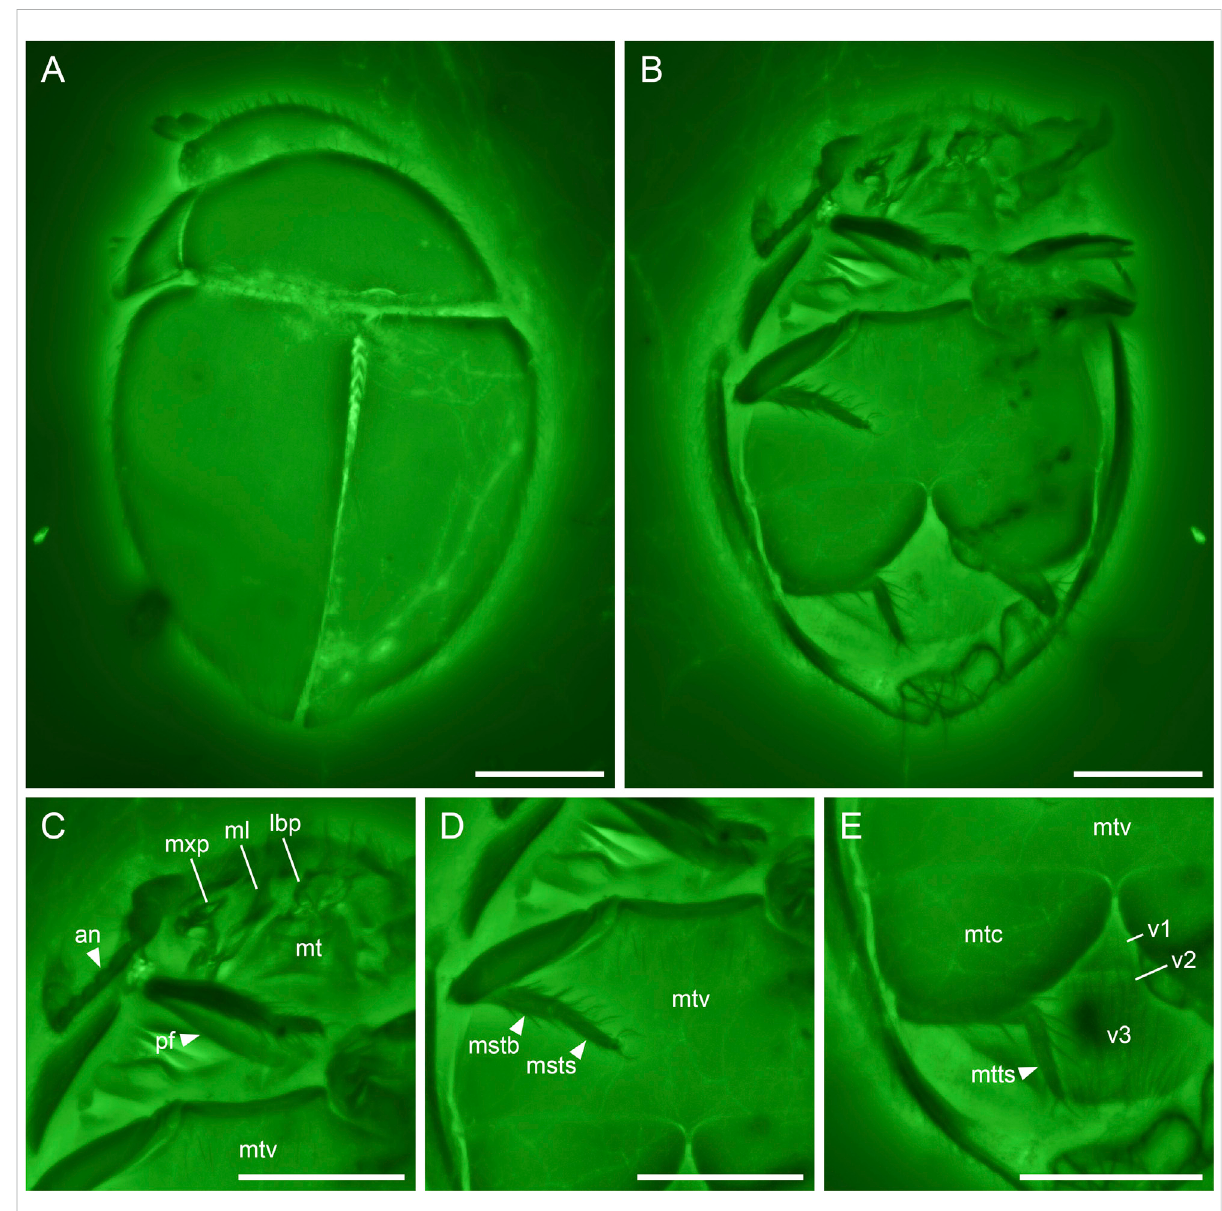
FIGURE 4 Crowsonaeriusminutus Li&Caigen.etsp.nov.,holotype,NIGP178178,underconfocalmicroscopy. (A) Habitus,dorsalview. (B) Habitus,ventral view. (C) Head and prothorax, ventral view. (D) Metathorax, ventral view. (E) Hind leg and abdomen, ventral view. Abbreviations: an, antenna; lbp, labial palp; mstb, mesotibia; msts, mesotarsus; ml, mala; mt, mentum; mtc, metacoxa; mtts, metatarsus; mtv, metaventrite; mxp, maxillary palp; pf, profemur; v1 – 3, ventrites 1 – 3. Scale bars: 100 μ